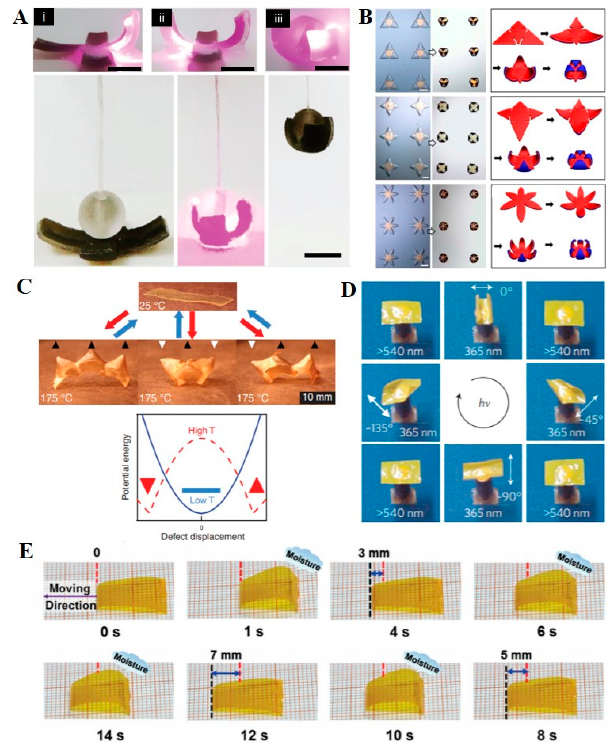
Figure 4. ( A ) Flexible anisotropic actuator upon near-infrared (NIR) irradiation from the flat to folded shapes. Reproduced with permission [55], copyright 2016, Royal Society of Chemistry. ( B ) Self-folding molybdenum disulfide (MoS 2 ) − SU8 structures with di ff erent shapes. Reproduced with permission [57], copyright 2019, American Chemical Society. ( C ) Thermally responsive liquid crystal elastomer (LCE) with mechanical multi-stability. Reproduced with permission [60], copyright 2015, AAAS. ( D ) Photoinduced soft actuators composed of liquid crystal polymer networks (LCNs). Reproduced with permission [61], copyright 2015, Nature Publishing Group. ( E ) Humidity-induced actuator composed of crosslinked liquid crystal polymers (CLCPs). Reproduced with permission [62], copyright 2017, Wiley-VCH.